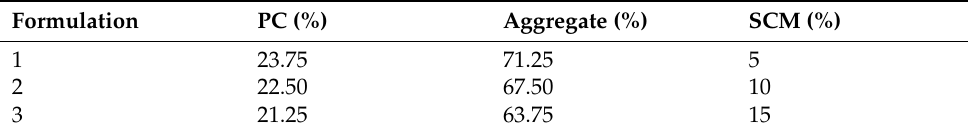
Table 1. Formulations of the investigated compositions.